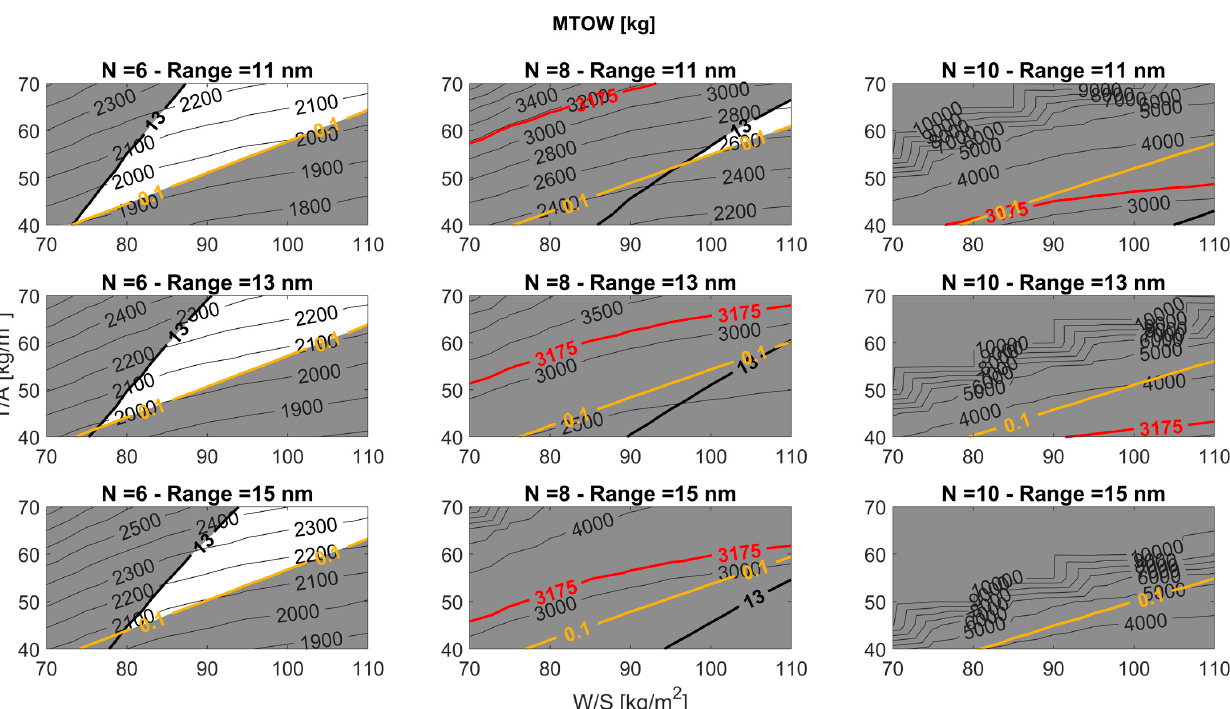
Figure 17. W/S vs. T/A charts of MTOW (future technology) varying number of rides and typical range of missions. Each plot shows a highlighted area, which identifies the design space compliant with the constraints.